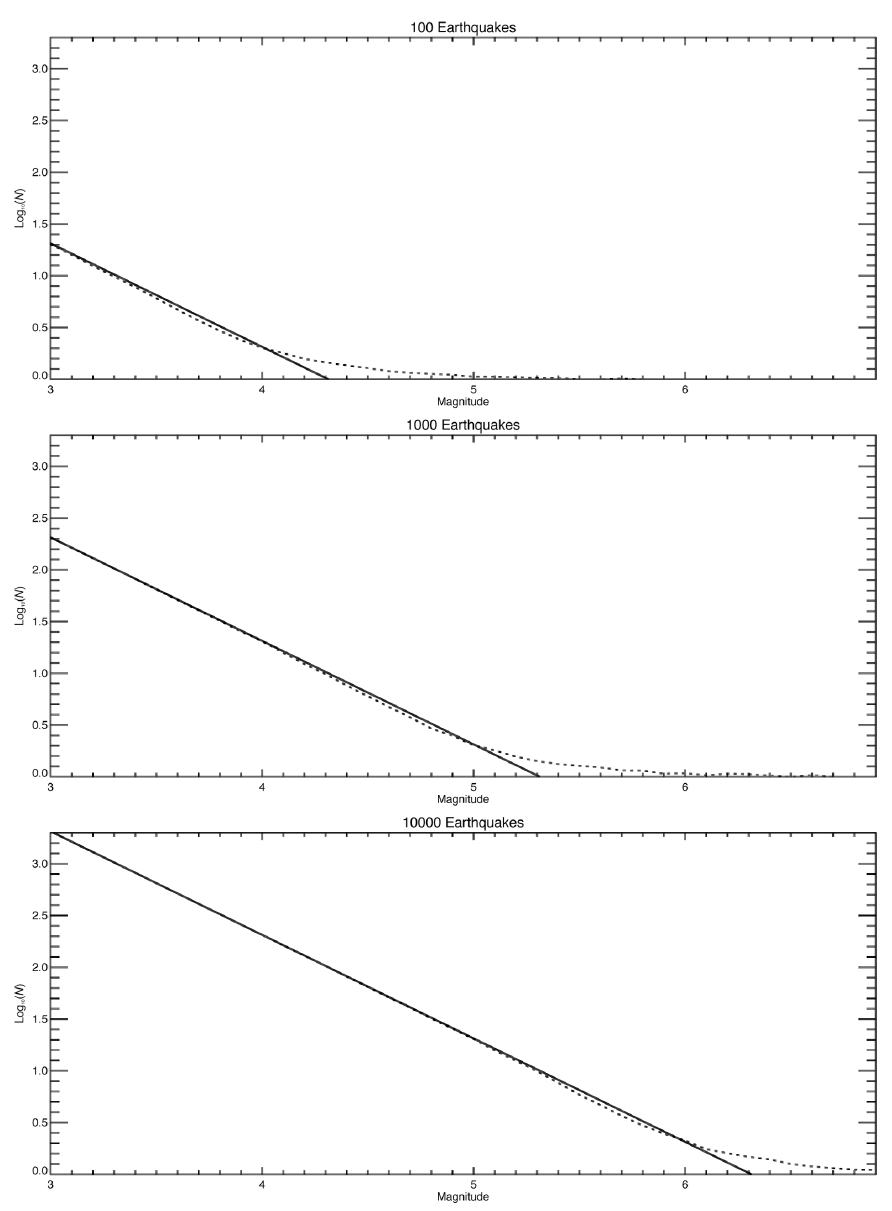
Fig. 3. Logarithm of the expected number of earthquakes (Log( ν i ); see text) according to the Gutenberg- Richter Law (solid line) and average of the logarithm of the generated number of events in each of 1000 syn- thetic catalogs (dotted line), plotted as a function of the magnitude, for different catalog sizes (from top to bot- tom : 100, 1000, 10000 events per catalog). The intersection between the solid and dotted lines represents the point where the bending changes in